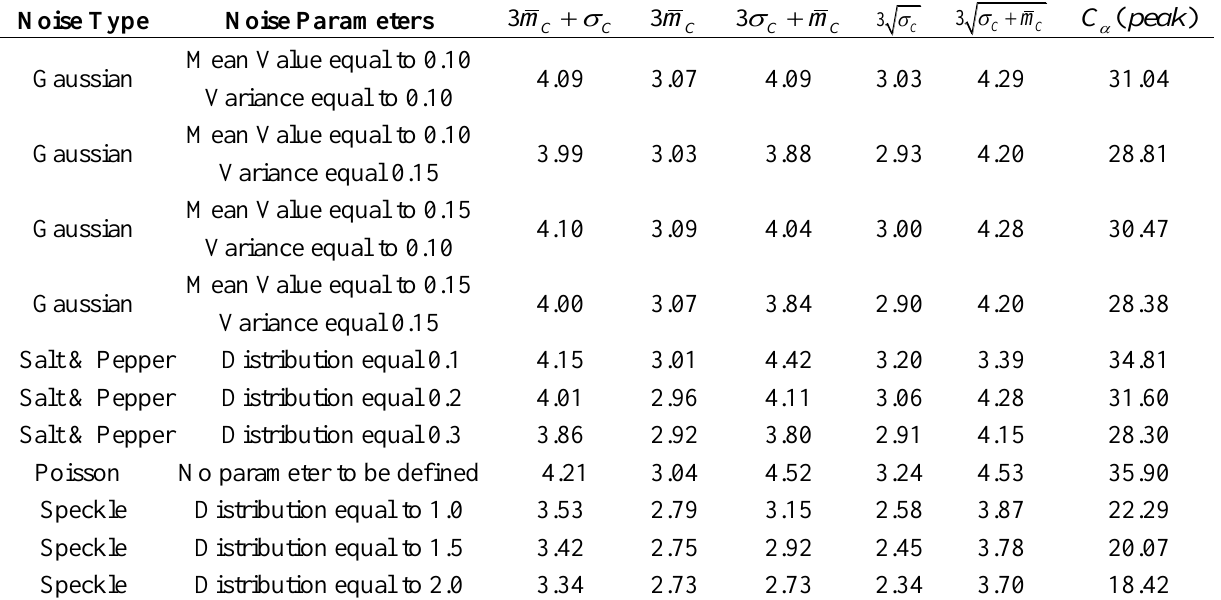
Table 1. Correlation values for different added noise, with related noise parameters. It has to be noted that statistical thresholds are constructed using correlation function mean value and standard deviation and are not directly connected to any noise function mean values and